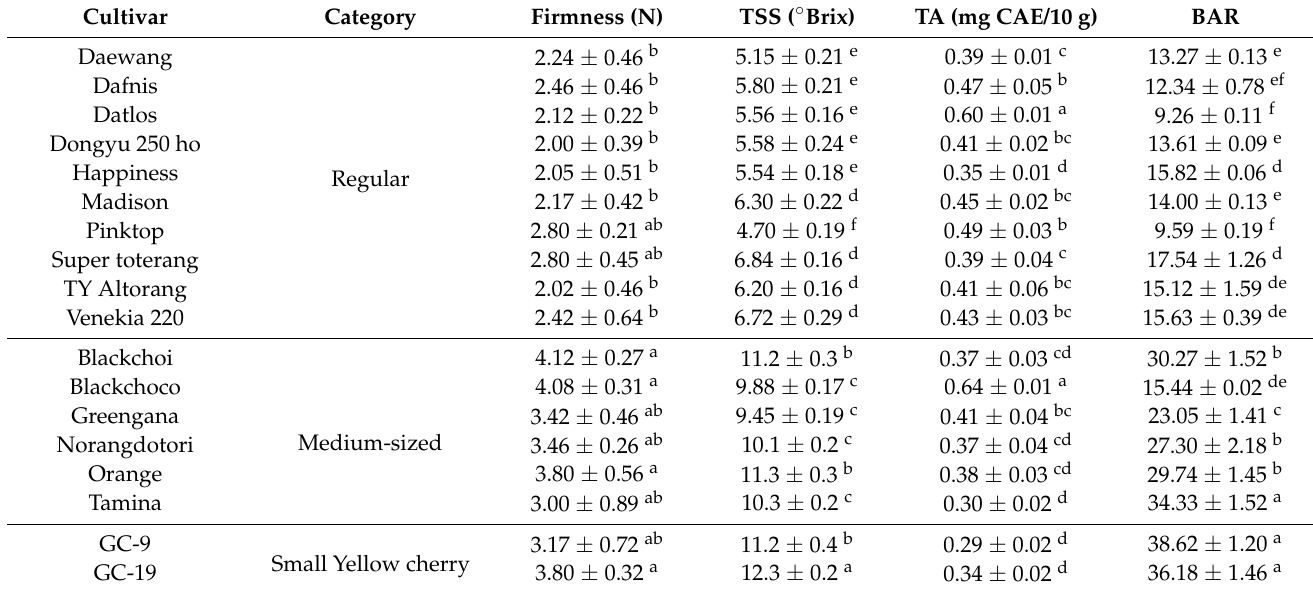
Figure 1. Eighteen tomato cultivars used in this study. Table 1. Firmness, TSS, TA, and BAR of eighteen tomato cultivars at red ripe stage.